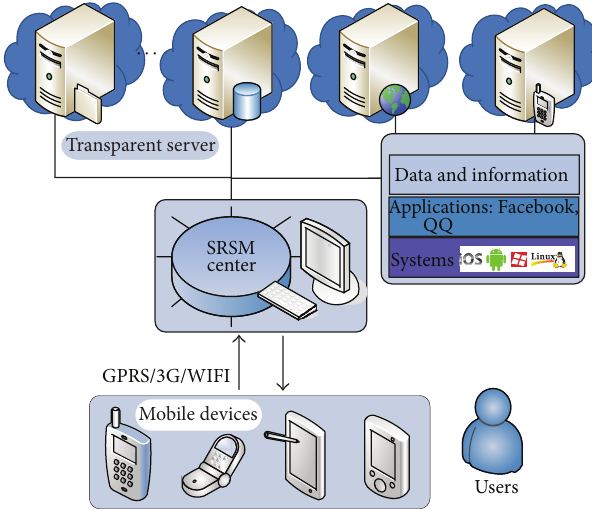
Figure 2: SRSM in mobile transparent